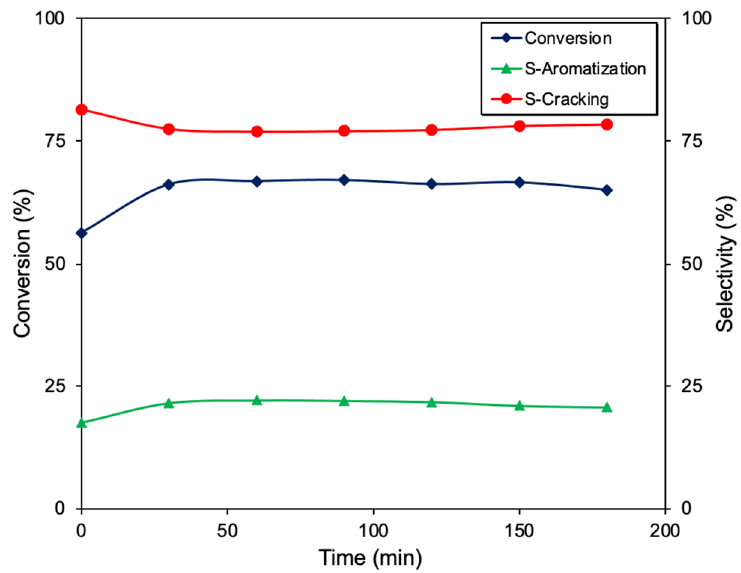
Figure 2. Conversion and products distribution obtained with Mo500 carbon aerogel at 550 °C, as a function of time on stream.